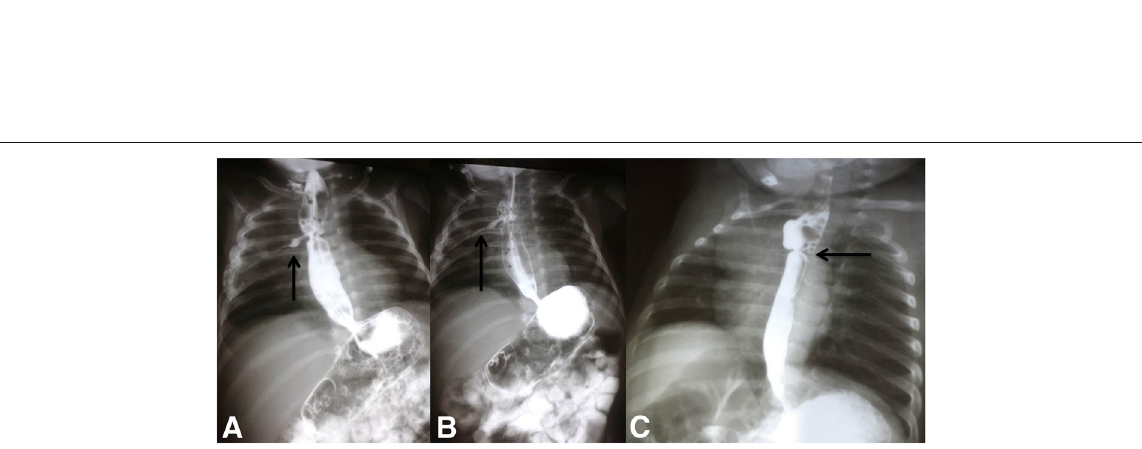
Fig. 6 Esophago-cutaneous fistula in a neonate after the repair of esophageal atresia. a , b Serial images of esophagogram showing the fistulous tract (arrows) and esophageal stricture. c Esophagogram after 1 month demonstrating occlusion of the fistula with persistence of the esophageal stricture (arrow)